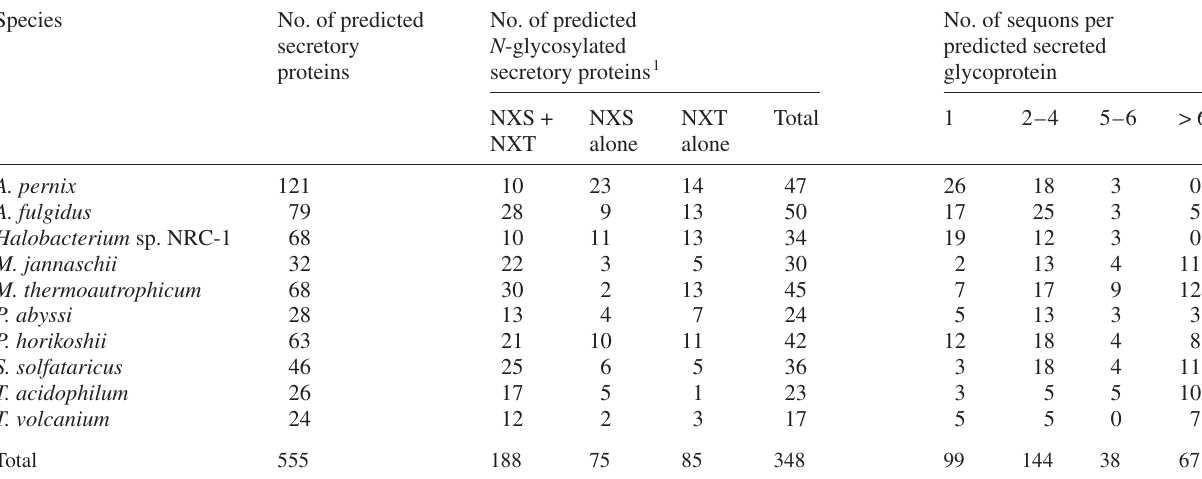
Table 2 . Tally of predicted N-glycosylated secretory proteins in selected archaeal